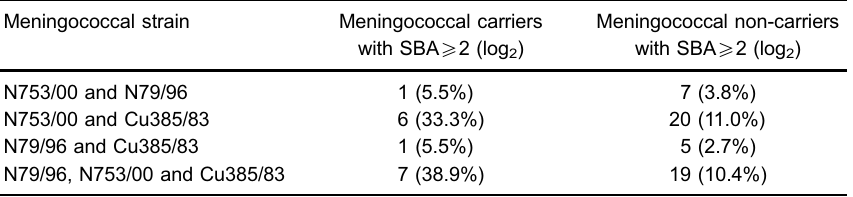
Table 4. Frequency of carriers (n=18) and non-carriers (n=182) with protective levels of serum bactericidal antibodies (SBA) against more than one meningococcal strain. Meningococcal strain